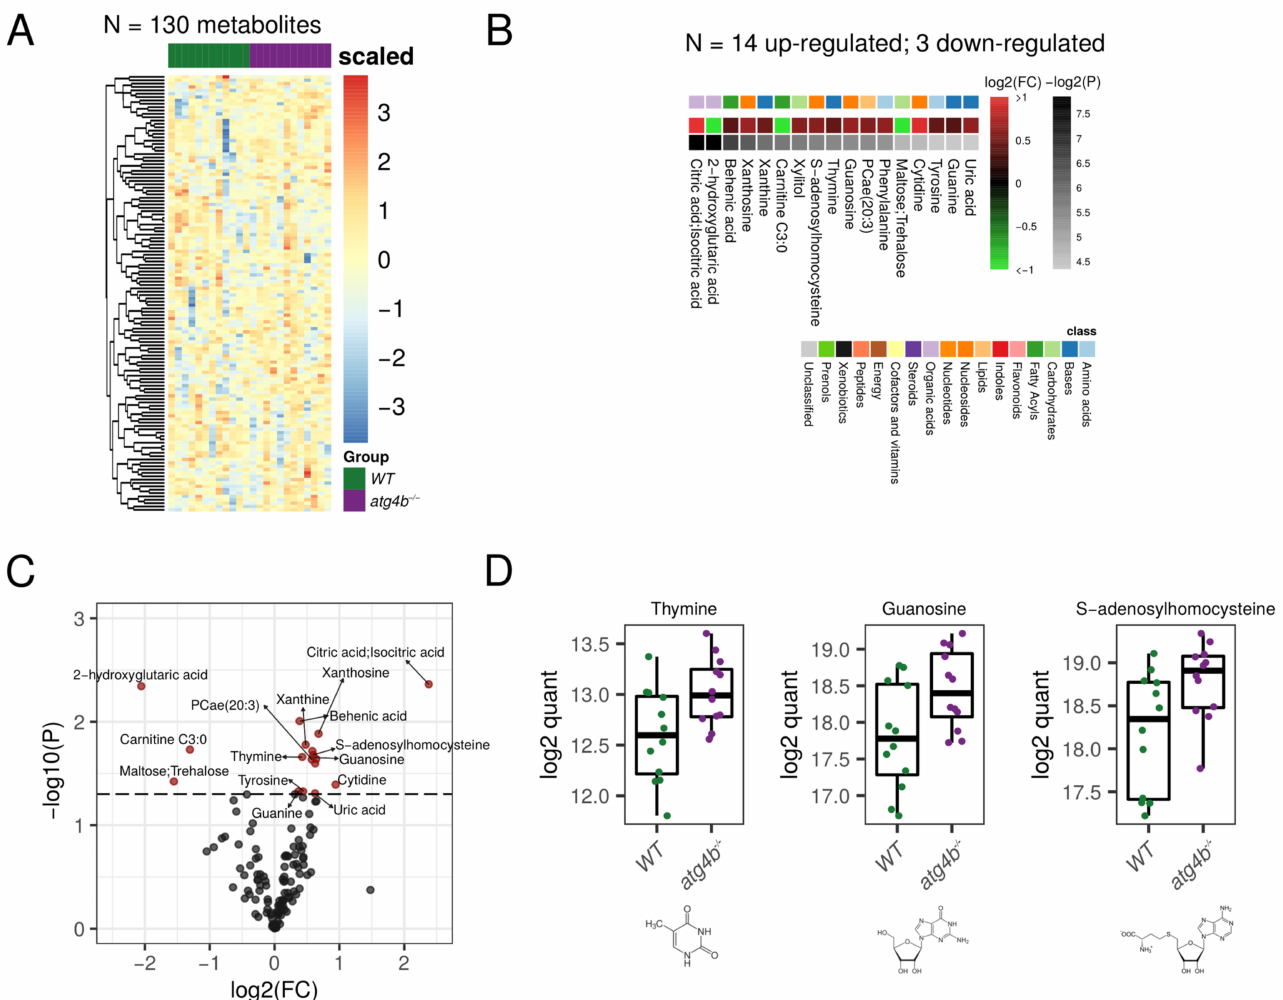
Figure 3. Autophagy deficiency upon ATG4B loss in heart. ( A ) Heatmap showing the row-scaled log2 quantification levels of all the profiled metabolites in heart tissue samples. ( B ) Heatmap describing the change (log2 of fold change) of the metabolites with significantly altered levels between WT and atg4b − / − samples. ( C ) Volcano plot comparing the effect size (log2 of fold change) to the significance ( − log10 of p -value) of the metabolites altered between WT and atg4b − / − samples. Significant metabolites are colored in red. Representative metabolites are labeled within the plot. ( D ) Boxplots showing the log2 quantification levels of three representative metabolites, which are significantly altered between WT and atg4b − / − samples. Significance is defined as an unadjusted p -value <